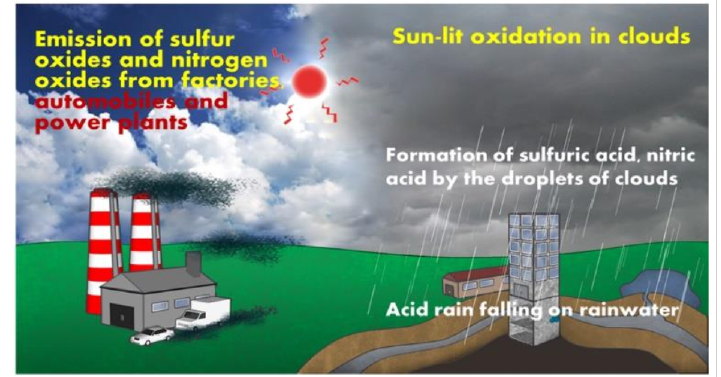
Figure 3. Groundwater pollution path.